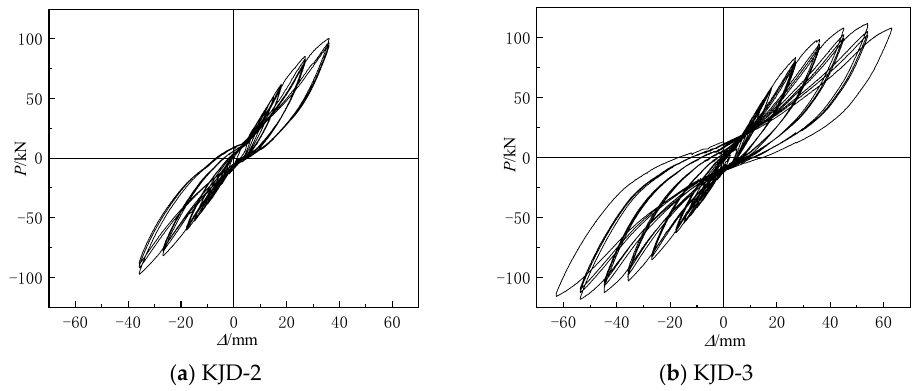
Figure 4. Hysteretic loops of pre-damage specimens. Table 3. Pre-damage and reinforcement method of specimens.